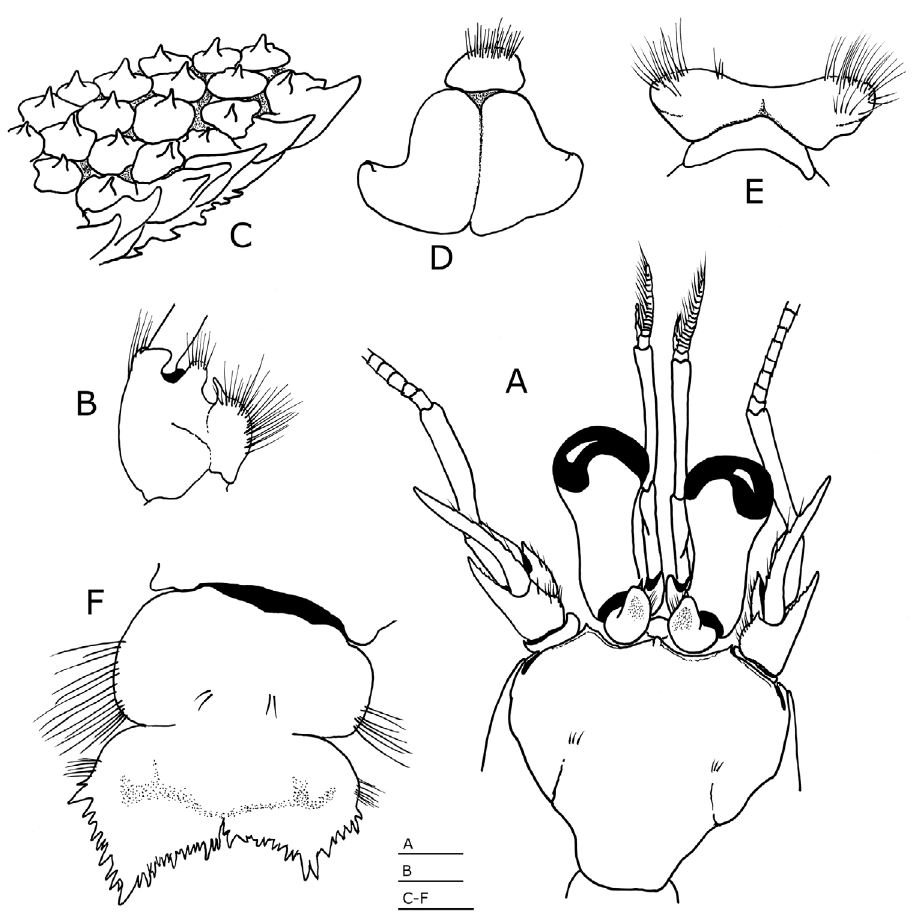
Figure 5. Pagurus smithi (Benedict, 1892), lectotype male 7.9 mm, northeastern Pacific, southern Gulf of California, Mexico, USFC Albatross, sta 2823 (USNM 16716): A , shield and cephalic appendages, dorsal view; B , right basal antennular segment, dorsal view; C , portion of dorsolateral surface of right chela near base of fixed finger and lateral margin of chela, dorsolateral view; D , anterior and posterior lobes of sternite XI (between third pereopods), ventral view; E , sternite XIII (between fifth pereopods), ventral view; F , telson, dorsal view. Scales = 2 mm (A), 1 mm (B,